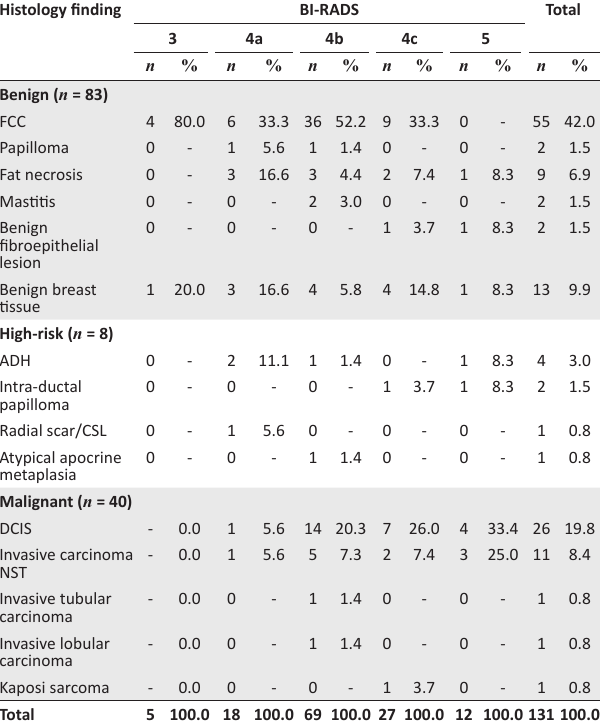
TABLE 3: Histopathological findings in 131 stereotactic biopsies and frequency in each breast imaging reporting and data system category. Histology